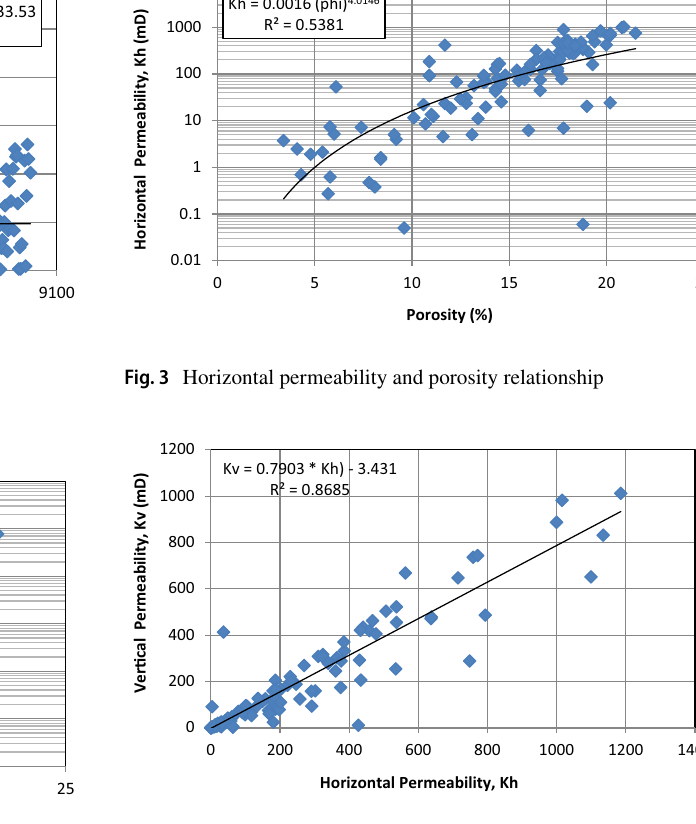
Fig. 4 Newly developed vertical–horizontal permeability relationship